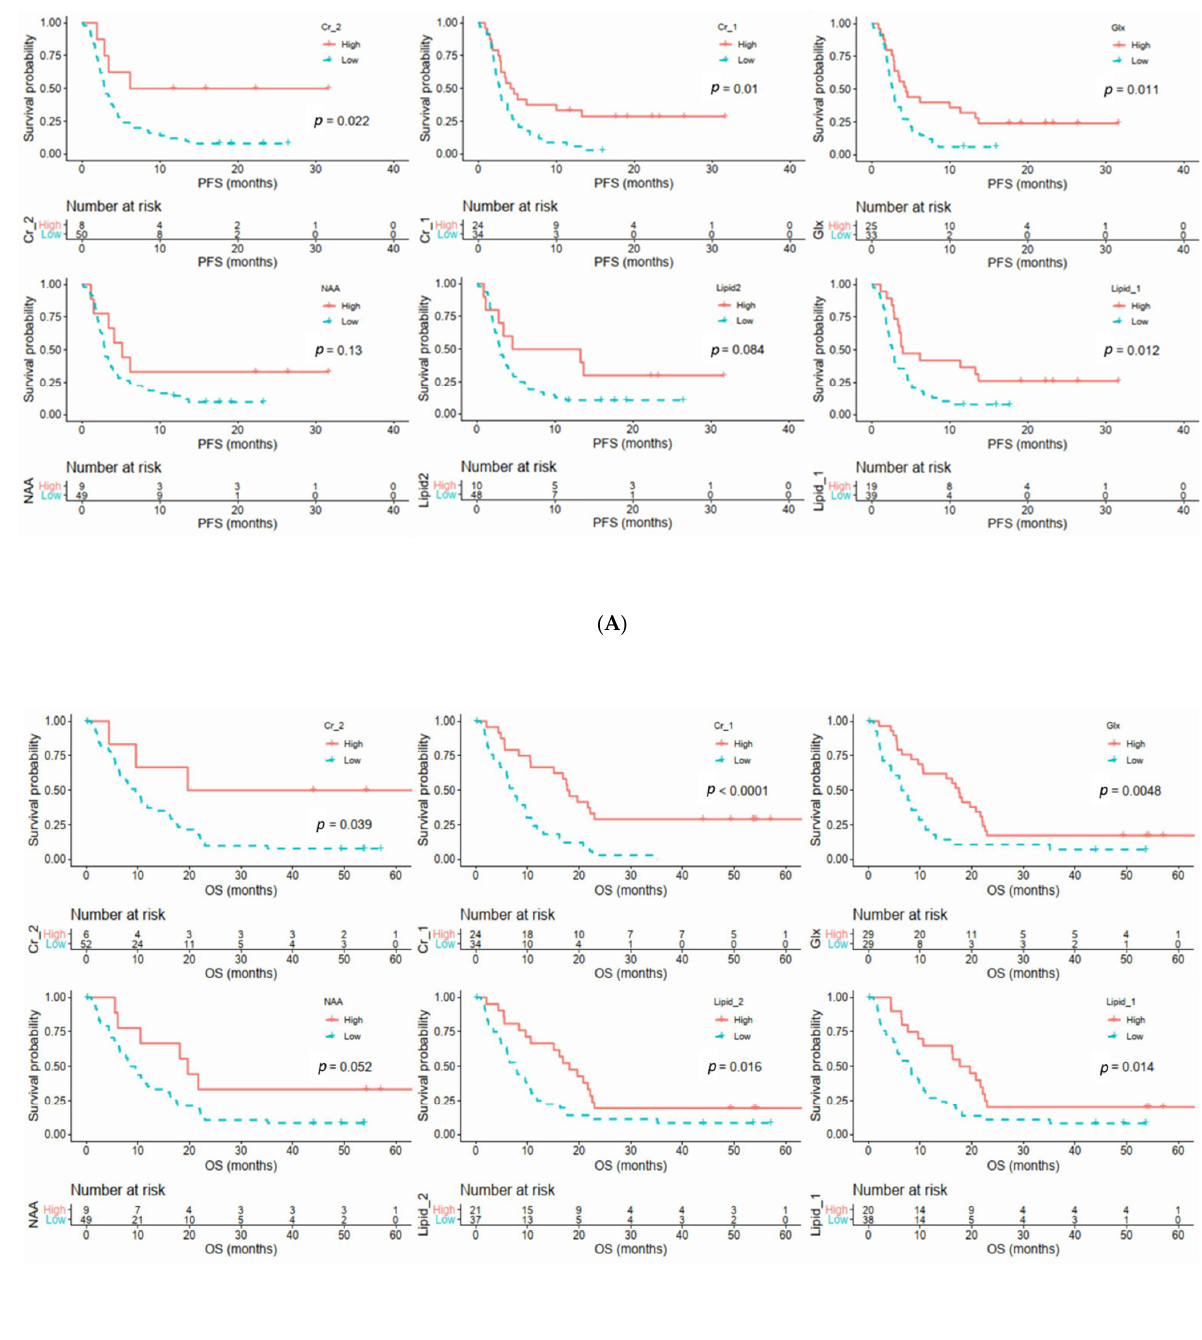
Figure 4. Kaplan–Meier curves of MRS metabolites of PFS ( A ) and OS ( B ). In multivariable analysis, both TNM stage ( p = 0.023) and Cr_2 ( p = 0.025) remained independent predictors of PFS; Cr_1 ( p = < 0.0001) remained independent predictor of OS (Table 4).